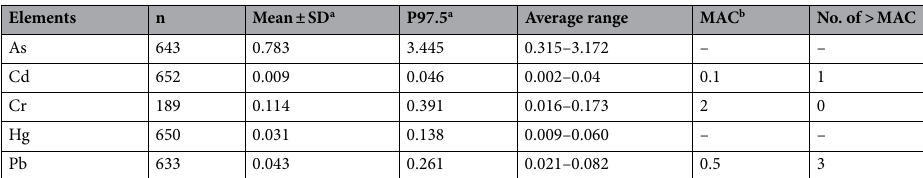
Table 2. The concentration of heavy metals in marine fish from Zhejiang province (mg/kg). a Target analytes with concentrations lower than LOD were treated as one-half of LOD when calculating the mean values; SD, standard deviation. b Maximum allowable concentrations of contaminants in foods.